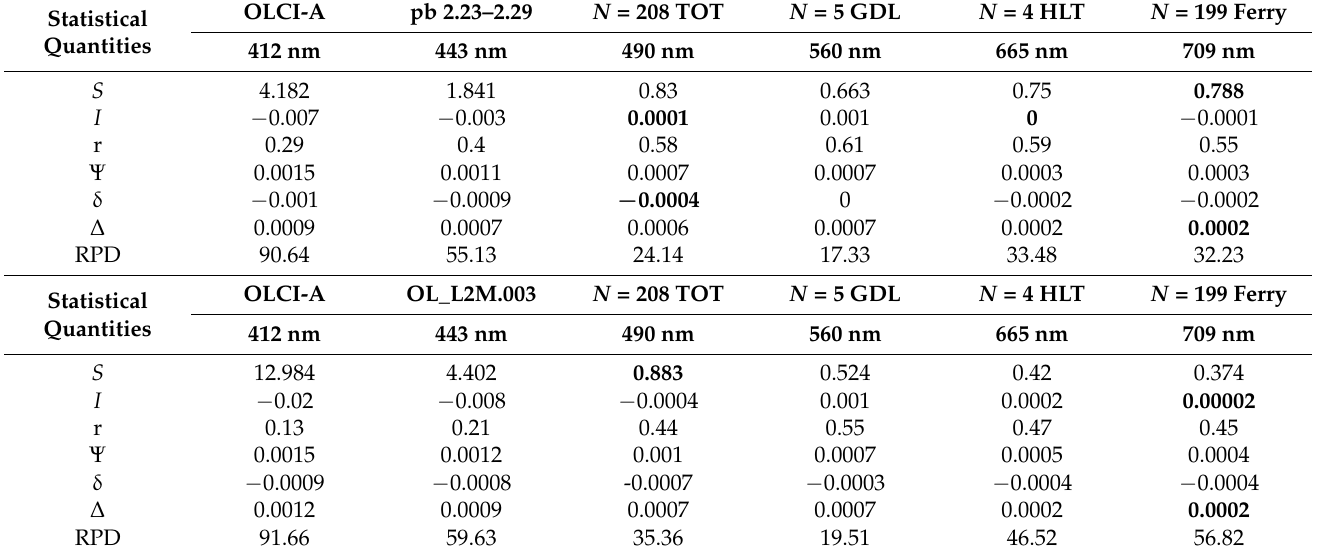
(Table 4). For MODIS-Aqua the spectra reproduced the shape of the in situ AERONET-OC data well, but not for the Alg@line data (Figure 6). MODIS-Aqua both overestimated and underestimated R rs (412) and R rs (443), as conveyed by the high S , I and RPD (Table 4). MODIS-Aqua performed better at 488, 560 and 667 nm with comparatively low I , Ψ , δ and ∆ and S close to 1, especially at 560 and 667 nm (Table